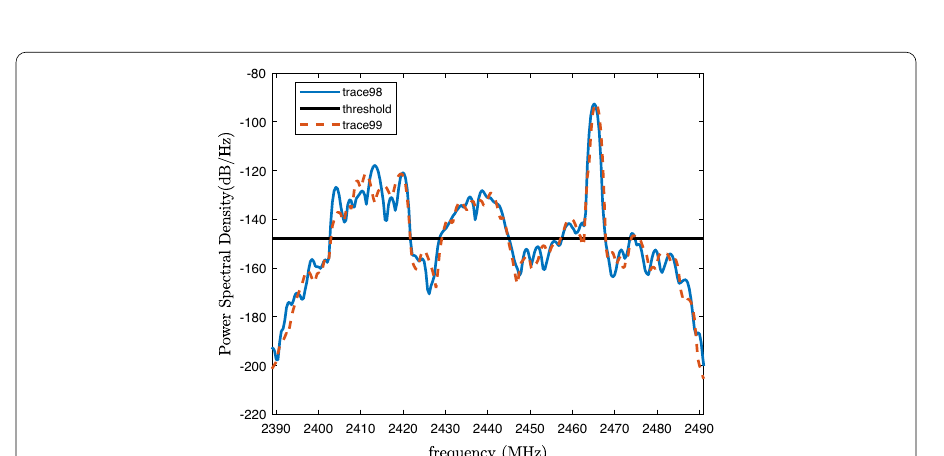
Fig. 17 Power spectral density of recorded interference for two successive